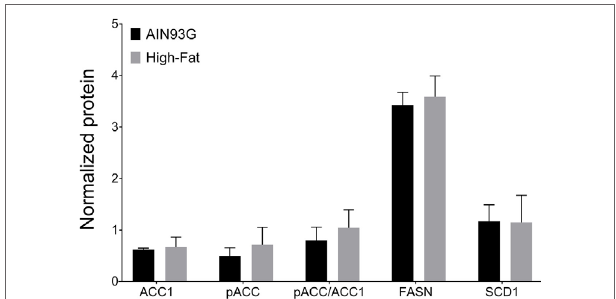
FigUre 9 | Expression of de novo lipogenesis enzymes fatty acid synthase (FASN), acetyl-CoA carboxylase-1 (ACC1), phosphorylated ACC1 (pACC), stearoyl-CoA desaturase-1 (SCD1), and the ratio of pACC to ACC1. The chemiluminescent signals of the target proteins were normalized to the signals of the system control protein. Values are mean ± SD ( n = 6 per